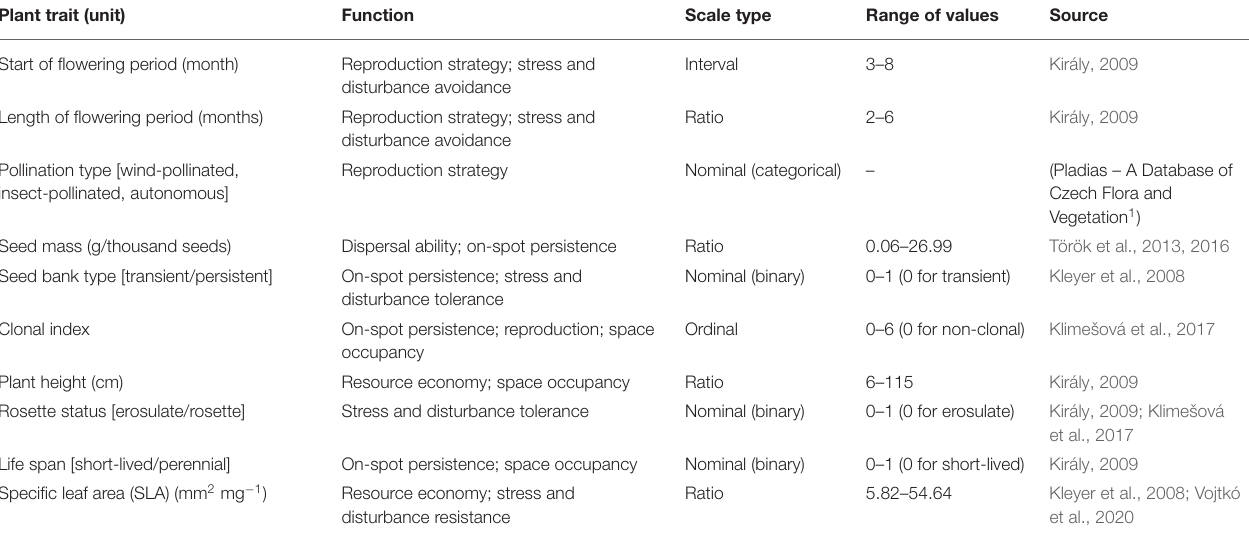
TABLE 2 | Plant traits considered, their function, scale type and range, and the source of trait